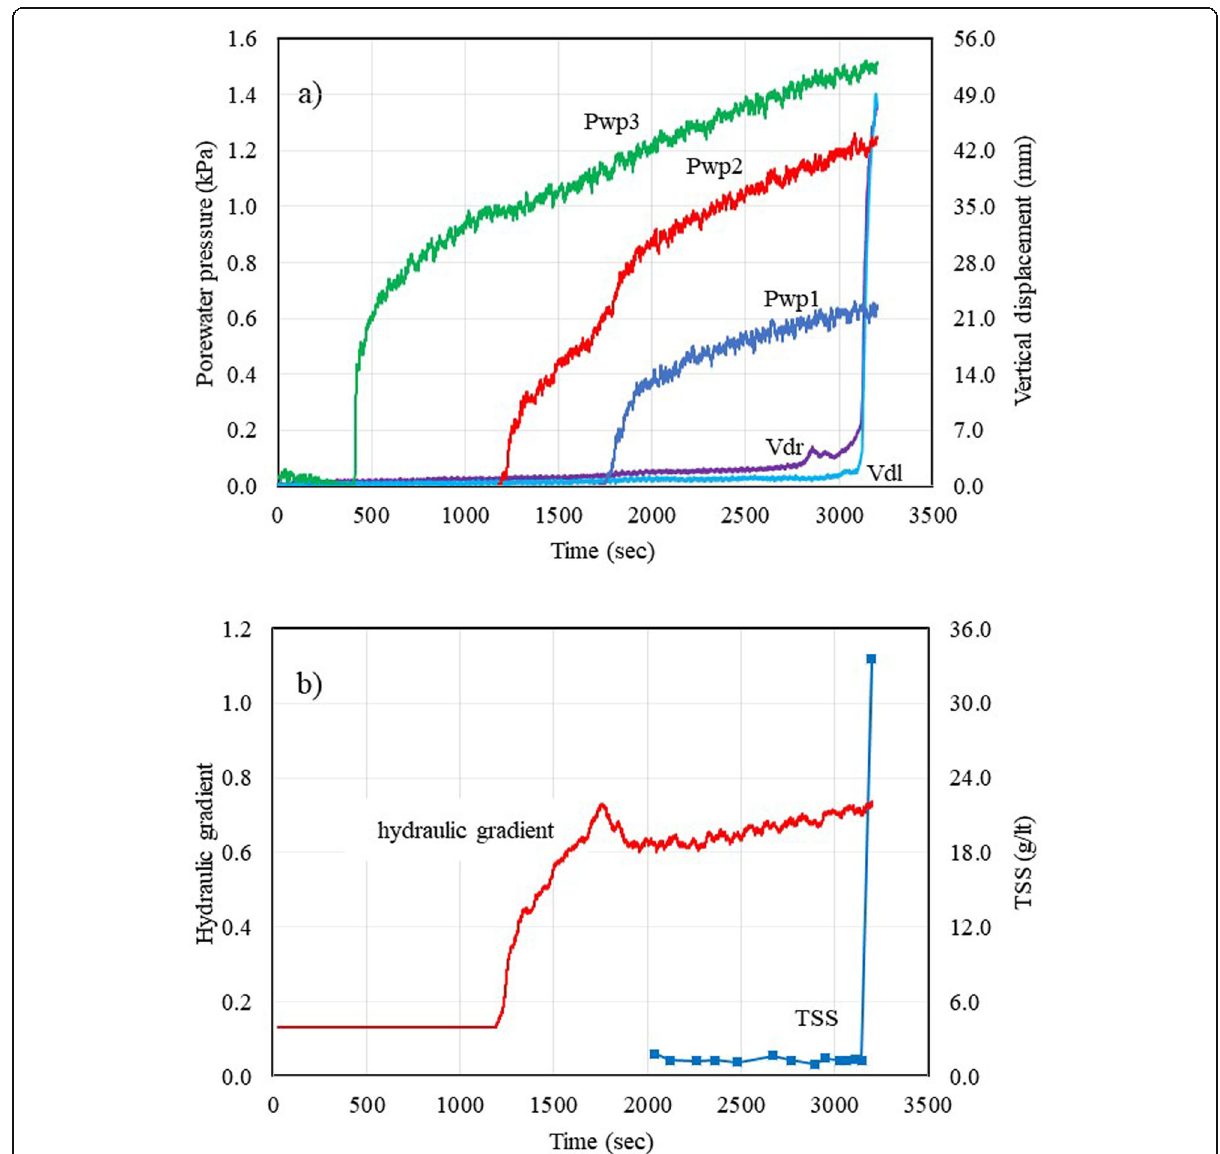
Fig. 4 Experiment results of experiment No. EXP 2F of GI sample. a Pore water pressure and vertical displacement, b Hydraulic gradient and